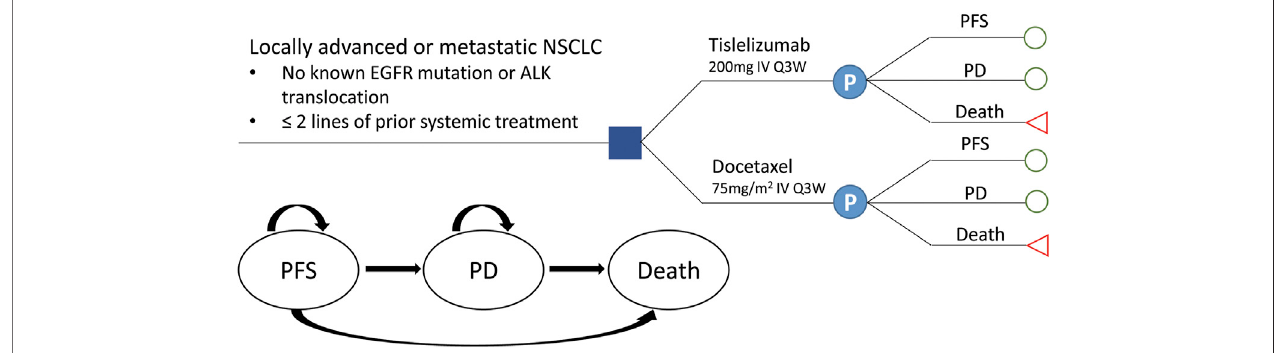
FIGURE 1 | Transition diagram for the three-state partitioned survival model simulating the development of locally advanced or metastatic NSCLC. NSCLC, non- small-cell lung cancer; PFS, progression-free survival; PD, progressive